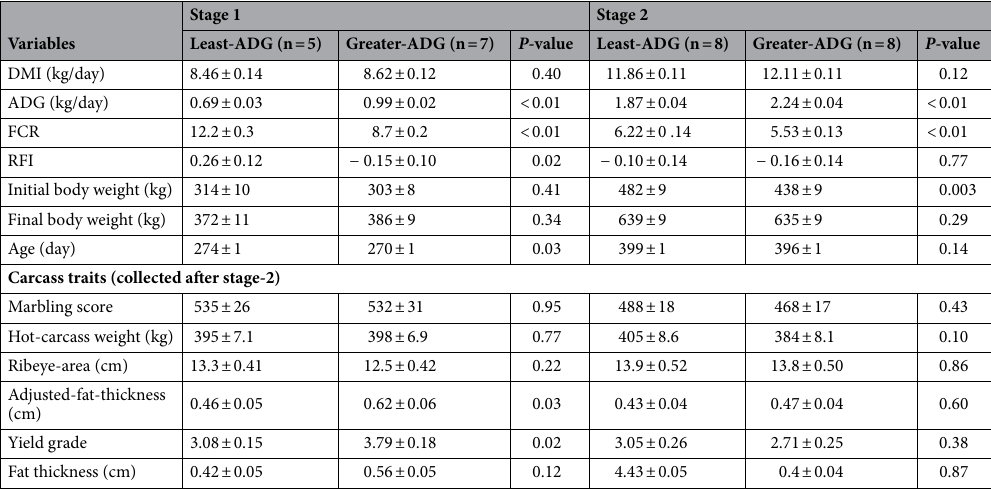
Table 1. Performance characteristics (means ± SE) of the steers selected at the end of stage-1 (forage) and stage-2 (concentrate) and carcass traits at slaughter according to differences in ADG with those with the greatest ADG and least ADG, whose dry matter intake was within 0.32 SD of the mean intake. Steers classified as greater- or least-ADG in stage-1 were not the same steers classified in stage-2. *Daily average dry